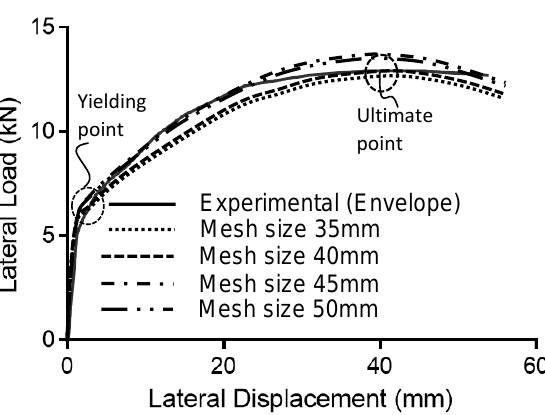
Figure 8. Load-displacement response for joint J1 according to different mesh sizes.